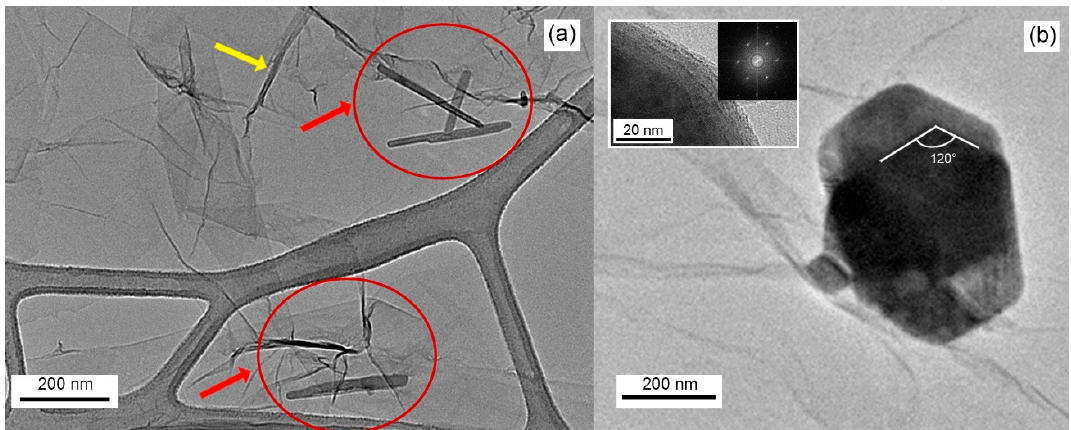
Figure 2. High-resolution TEM of WS 2 -decorated rGO showing: ( a ) light-grey background of interconnected GO flakes. Darker grey lines (yellow arrow) corresponding to folded GO edges and some WS 2 flakes vertically placed on GO flakes (needless inside the red circle); ( b ) a big hexagonal WS 2 flake. The inset shows a magnification of the flake’s edges with related SAED analysis pattern.